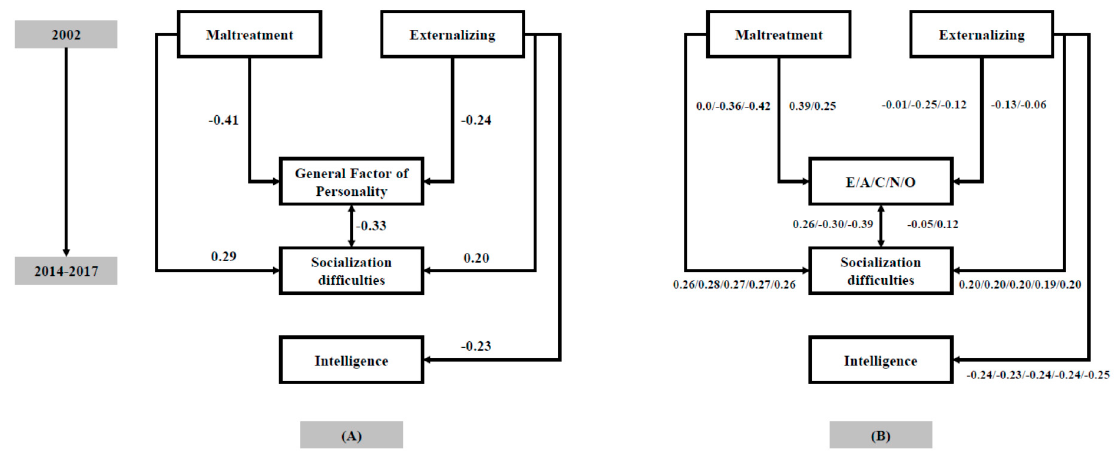
Figure 1. ( A ) Path analysis relating childhood maltreatment and externalizing behaviors with adult intelligence and personality variables; ( B ) Path analyses computed separately for the traits included in the five-factor model (FFM).